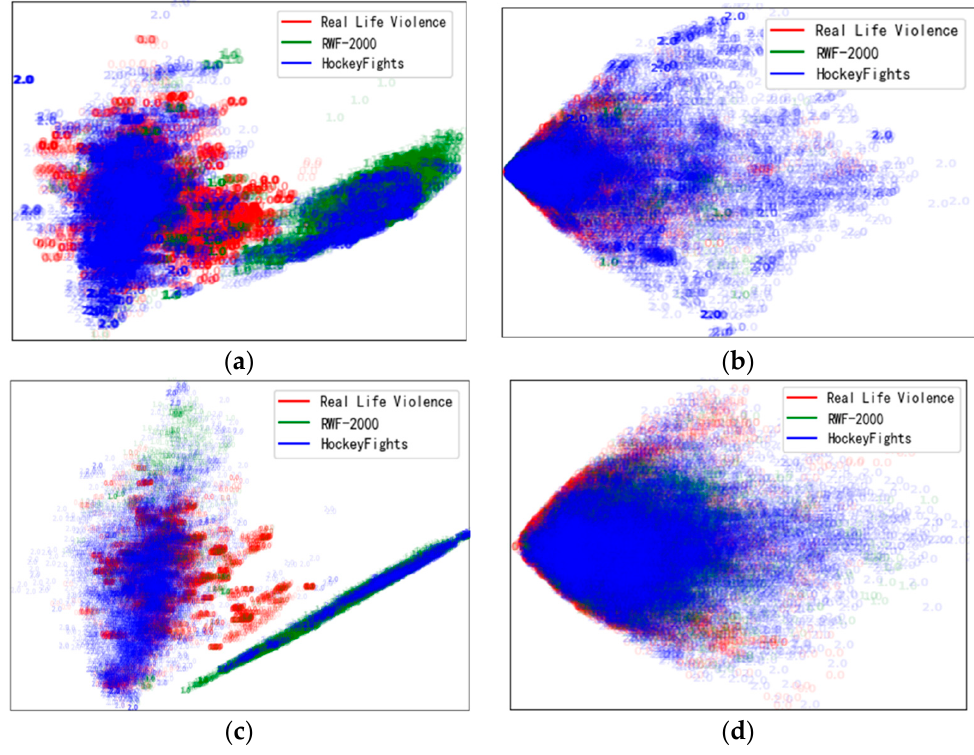
Figure 7. The training process of Deeplab-V3plus.